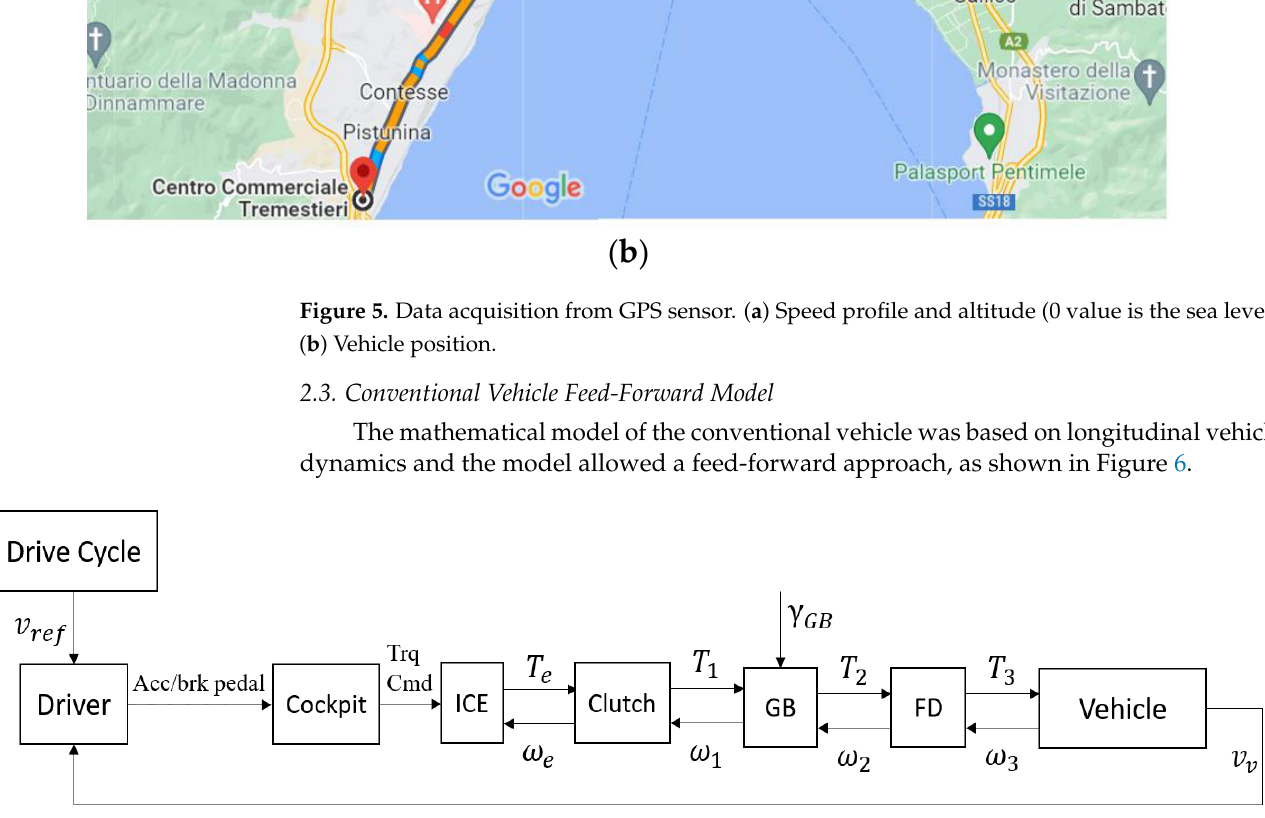
Figure 6. Conventional vehicle feed-forward model scheme. ICE: Internal Combustion Engine, Clutch, GB: gearbox, FD: final drive, 𝛾 The main elements were: Driver. The task of the driver block was to match the vehicle speed 𝒗 𝒗 with the reference speed 𝒗 𝒓𝒆𝒇 acquired during the driving cycle, through a controller (PI type) acting on the throttle/brake pedal position. Internal Combustion Engine (ICE). It received the information from the cockpit block (torque command) in order to develop the required torque 𝑇 𝑒 .